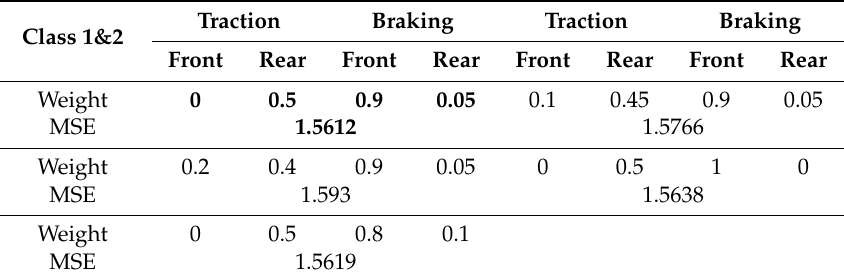
Table 7. Weight selection of Weighted Average in Class 1 and 2 states.